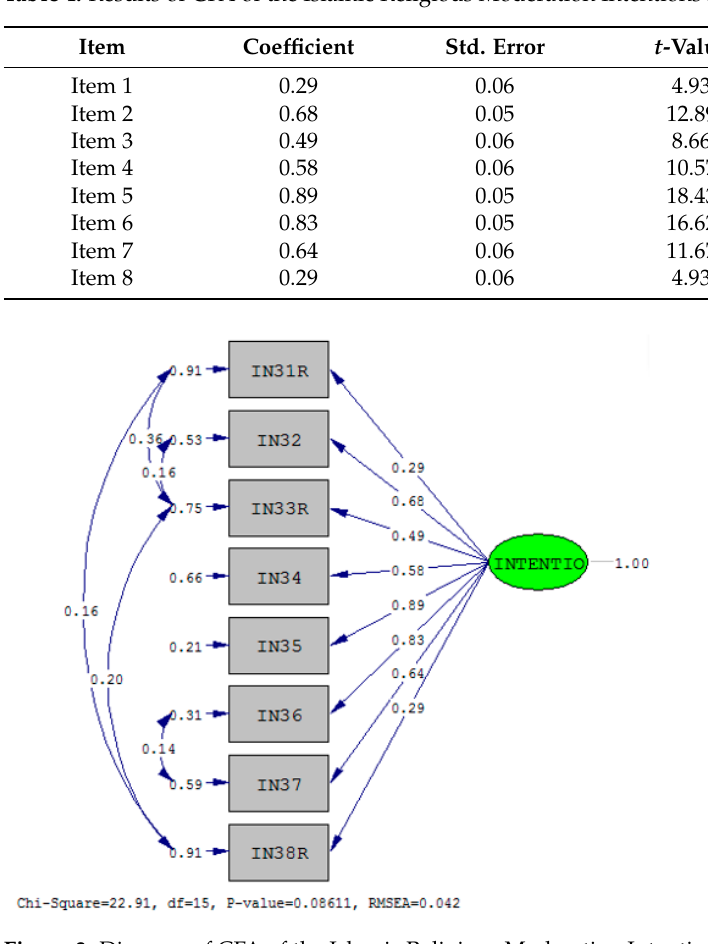
Figure 3. Diagram of CFA of the Islamic Religious Moderation Intentions Scale.